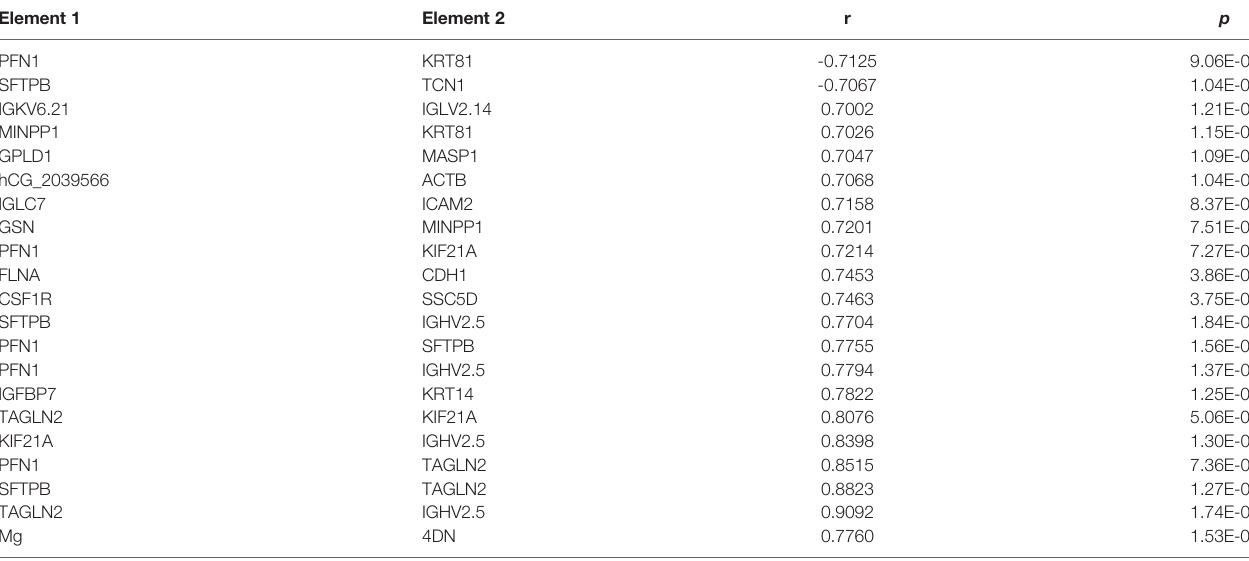
TABLE 1 | The details of signi fi cant correlations related to proteins or Mg. Element 1 Element 2